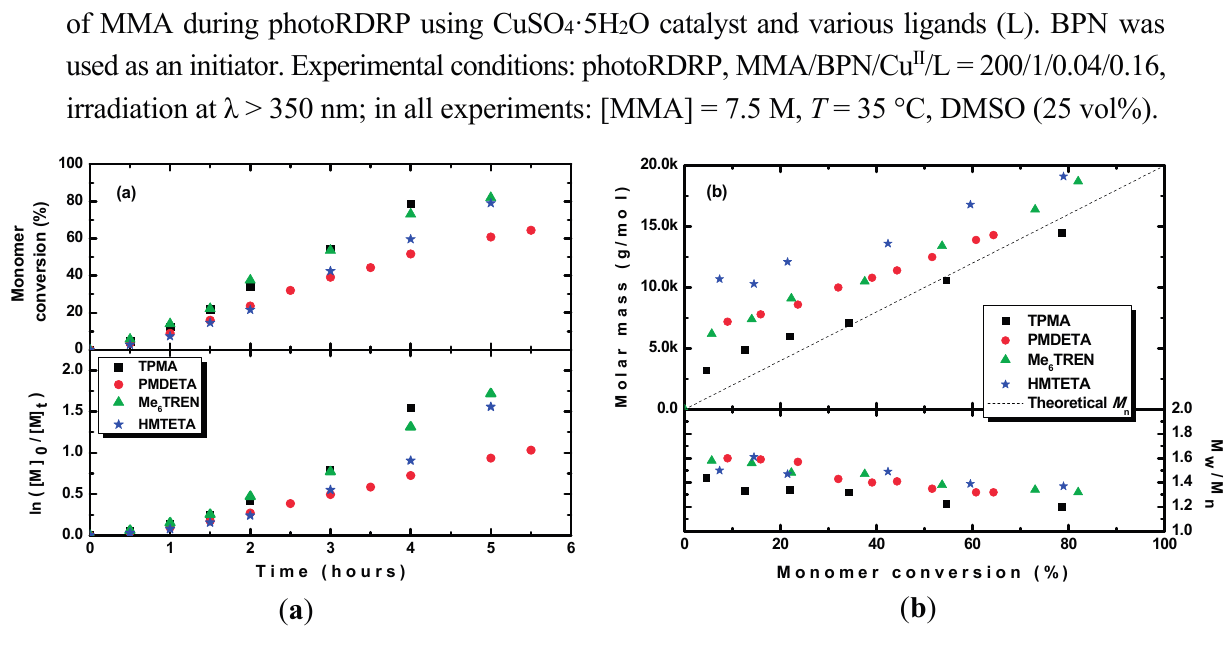
Figure 4. ( a ) Kinetic plots and ( b ) evolution of the molar mass and M w / M n with the